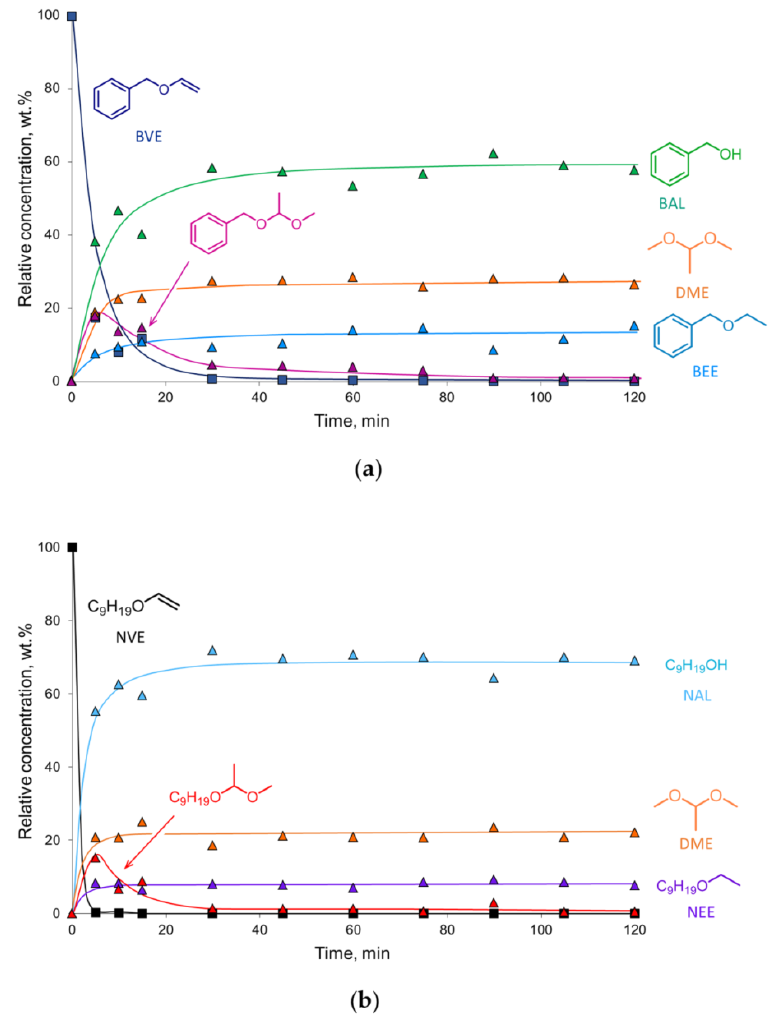
Figure 3. Reaction composition–time profiles of the hydrogenation of BVE ( a ) and NVE ( b ) over the 2% Pd-CCs/P278-E catalyst. Reaction conditions: 20 mg catalyst (3.8 µ mol Pd), 50 mg sub- strate, 2.0 mL MeOH, 295 K, 1.0 MPa H 2 . The products were identified by NMR and GC–MS (see Supplementary Materials).